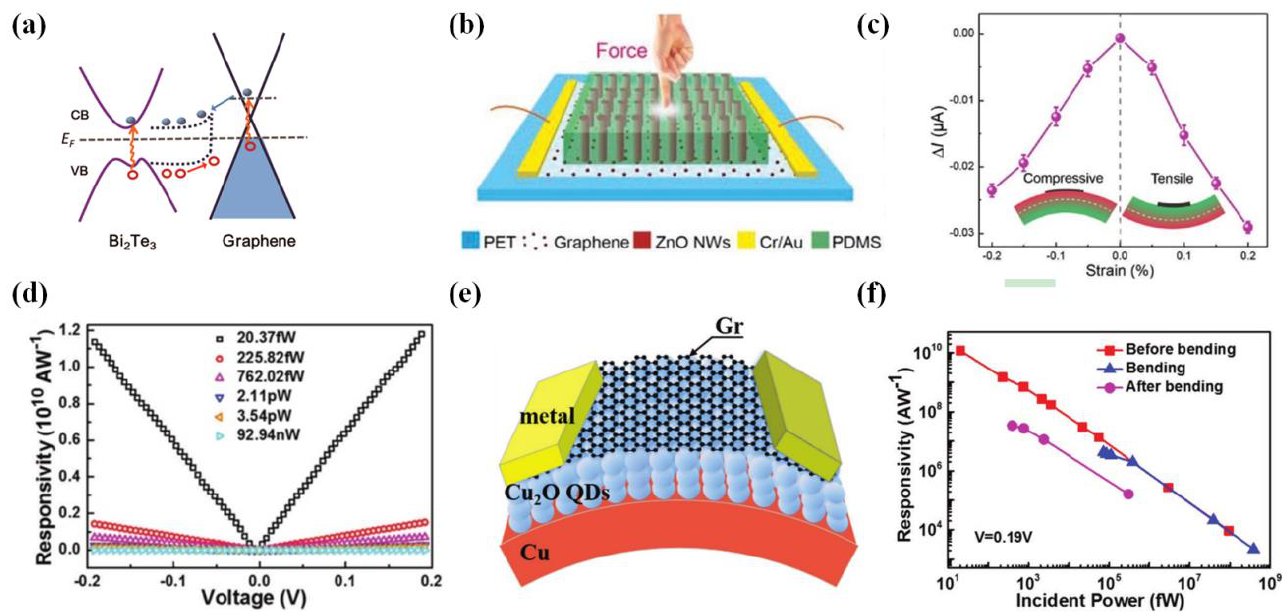
Figure 3. ( a ) Band diagram of a graphene Bi 2 Te 3 heterojunction. Blue dots represent photogenerated electrons, while red hollow dots represent holes. Reproduced with permission [87]. Copyright © 2022, American Chemical Society. ( b ) Schematic diagram of the graphene/ZnO nanowire array de- vice. ( c ) Current response for the different bending strains, where negative and positive strains de- note compressive (left inset) and tensile (right inset) strains, respectively. Reproduced with permis- sion [98]. Copyright © 2022 WILEY-VCH Verlag GmbH & Co. KGaA, Weinheim. ( d ) Responsivity as a function of the bias under different incident powers (under 450 nm illumination). ( e ) Illustration of the bent PD. ( f ) Responsivity versus incident power for the PD before bending, bending with a curvature of 40 mm, and after bending. Reproduced with permission [101]. Copyright © 2022